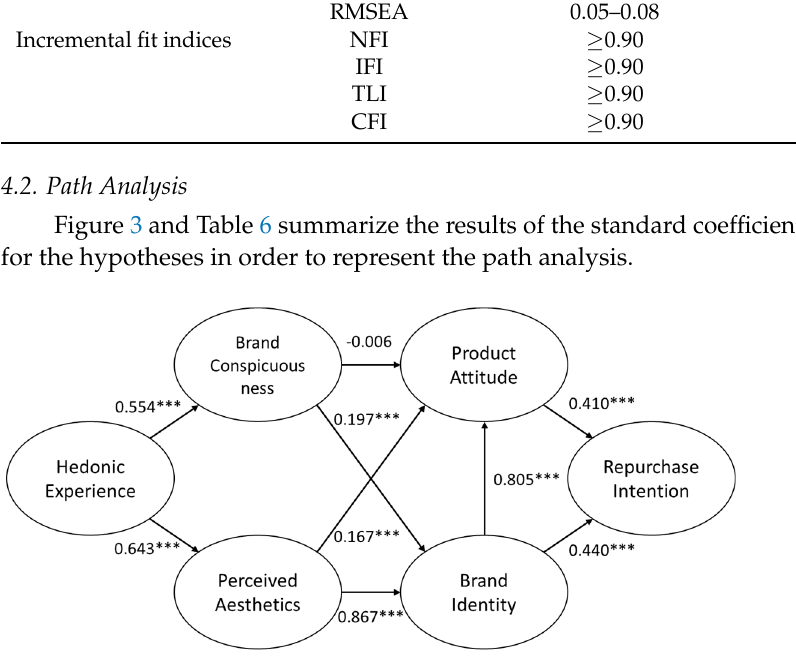
Figure 3. Path analysis for the structural equation model (SEM). Note: *** p < 0.01. Table 6. Results of the path analysis and testing of the hypotheses.